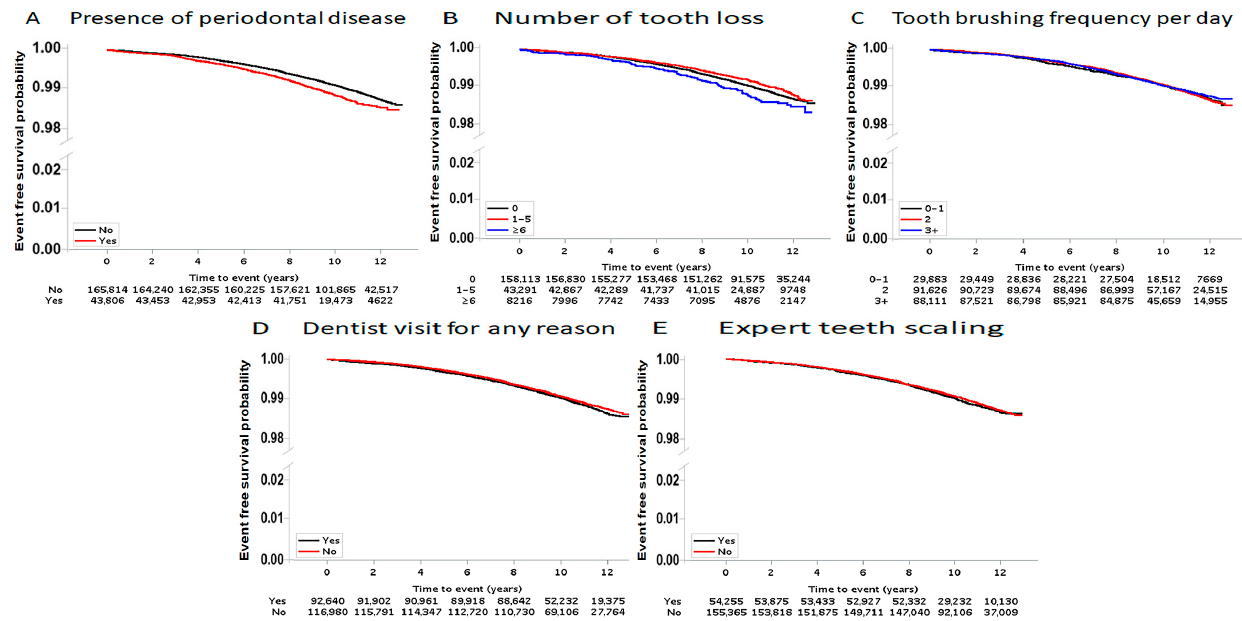
Figure 2. Kaplan–Meier survival curves associated with oral hygiene parameters and the presence of periodontal disease for the risk of cerebral aneurysm development. The Kaplan–Meier curves shows that the risk of cerebral aneurysm development depends on the presence of periodontal disease ( A ) ( p < 0.001) and the number of lost teeth ( B ) ( p = 0.001), but not tooth brushing frequency per day ( C ) ( p = 0.846), dental visits for any reason ( D ) ( p = 0.125), or expert teeth scaling ( E ) ( p = 0.337).